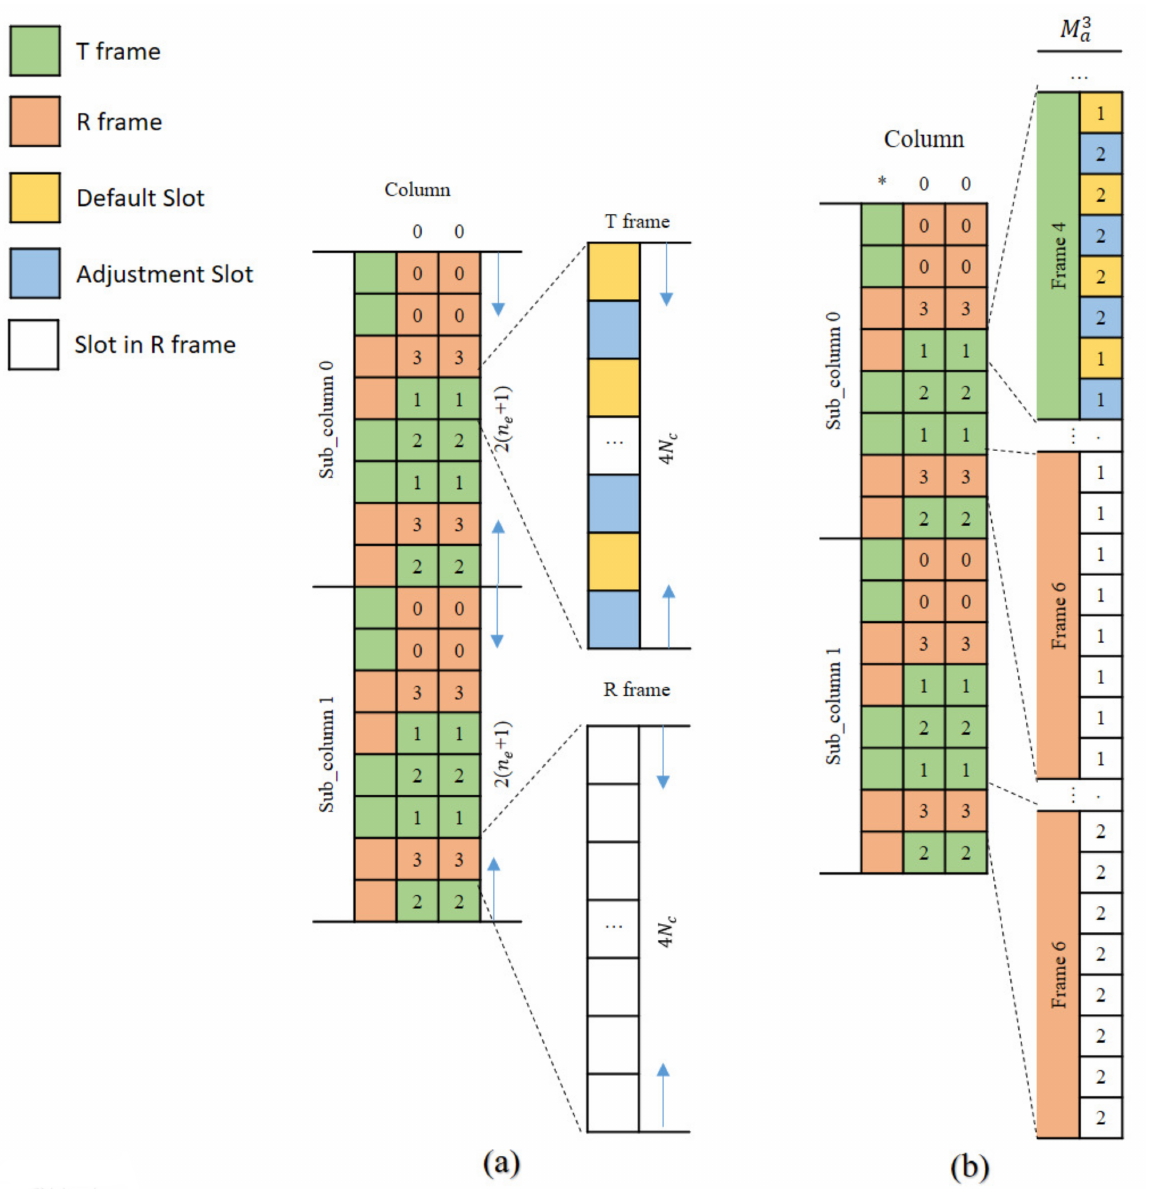
Figure 2. The hopping matrix structure of SU a is presented in two parts: ( a ) the allocation of T and R frames and slots, and ( b ) the channel allocation for frames 4 and 6 of Sub_column 0 and frame 7 of Sub_column 1 in M 3 a